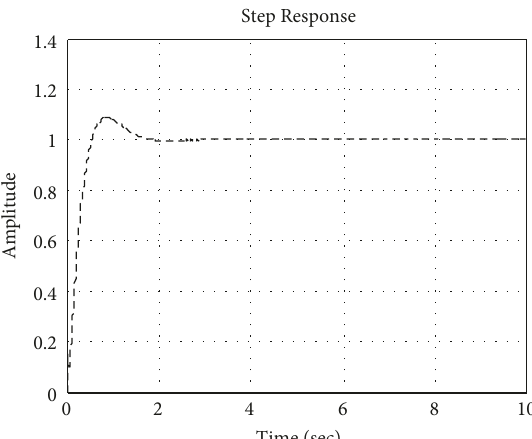
Figure 32: Response curve at 0.1 times β